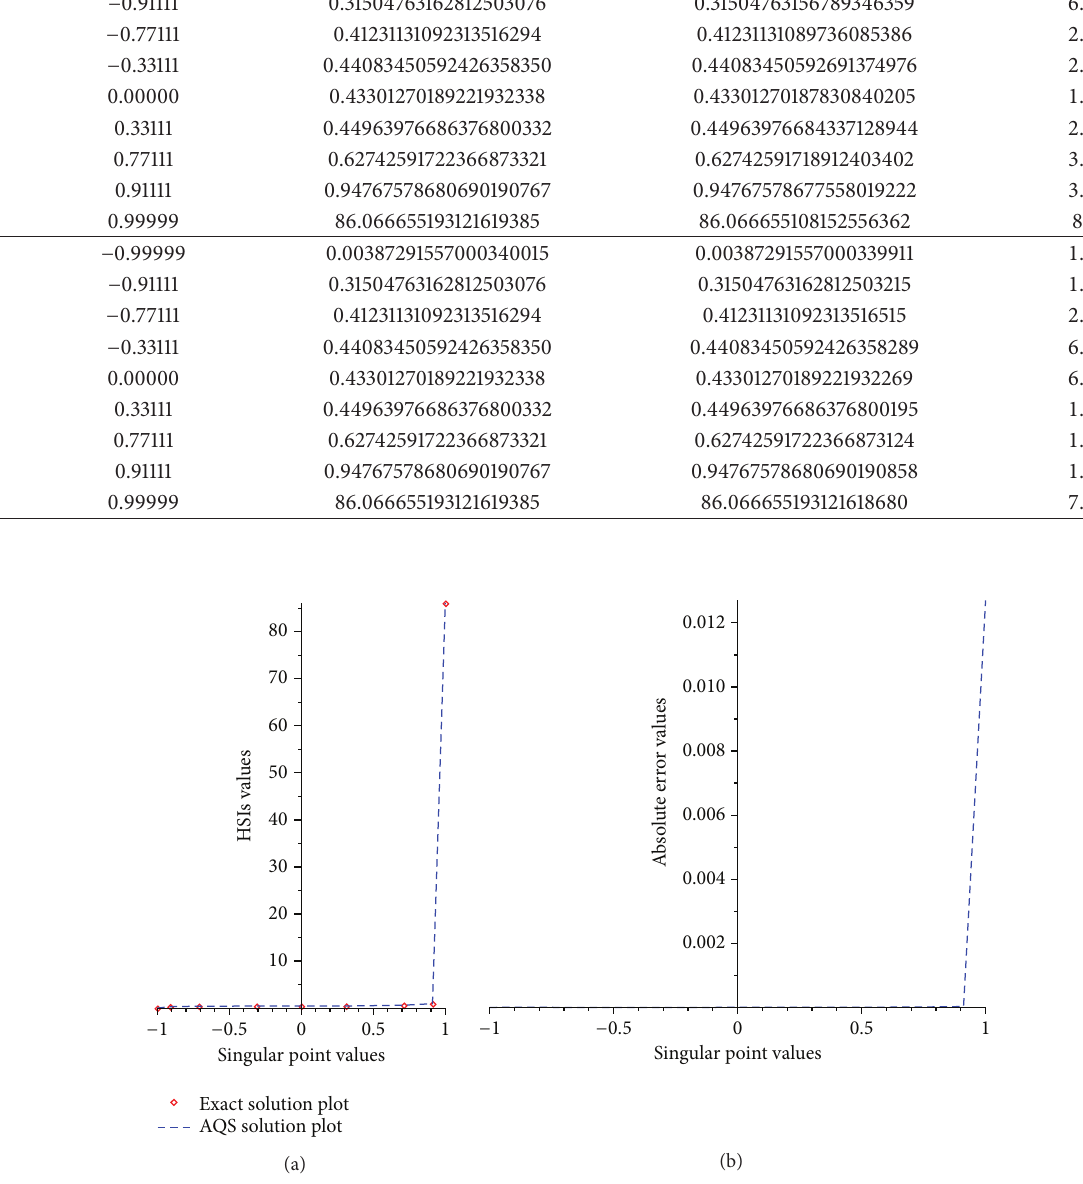
Figure 6: (a) Exact and AQS solutions when 𝑁 = 10 and ℎ(𝑡) = 1/(2 + 𝑡) and (b) absolute error between exact and AQS solution when 𝑁 = 10 and ℎ(𝑡) = 1/(2 + 𝑡)